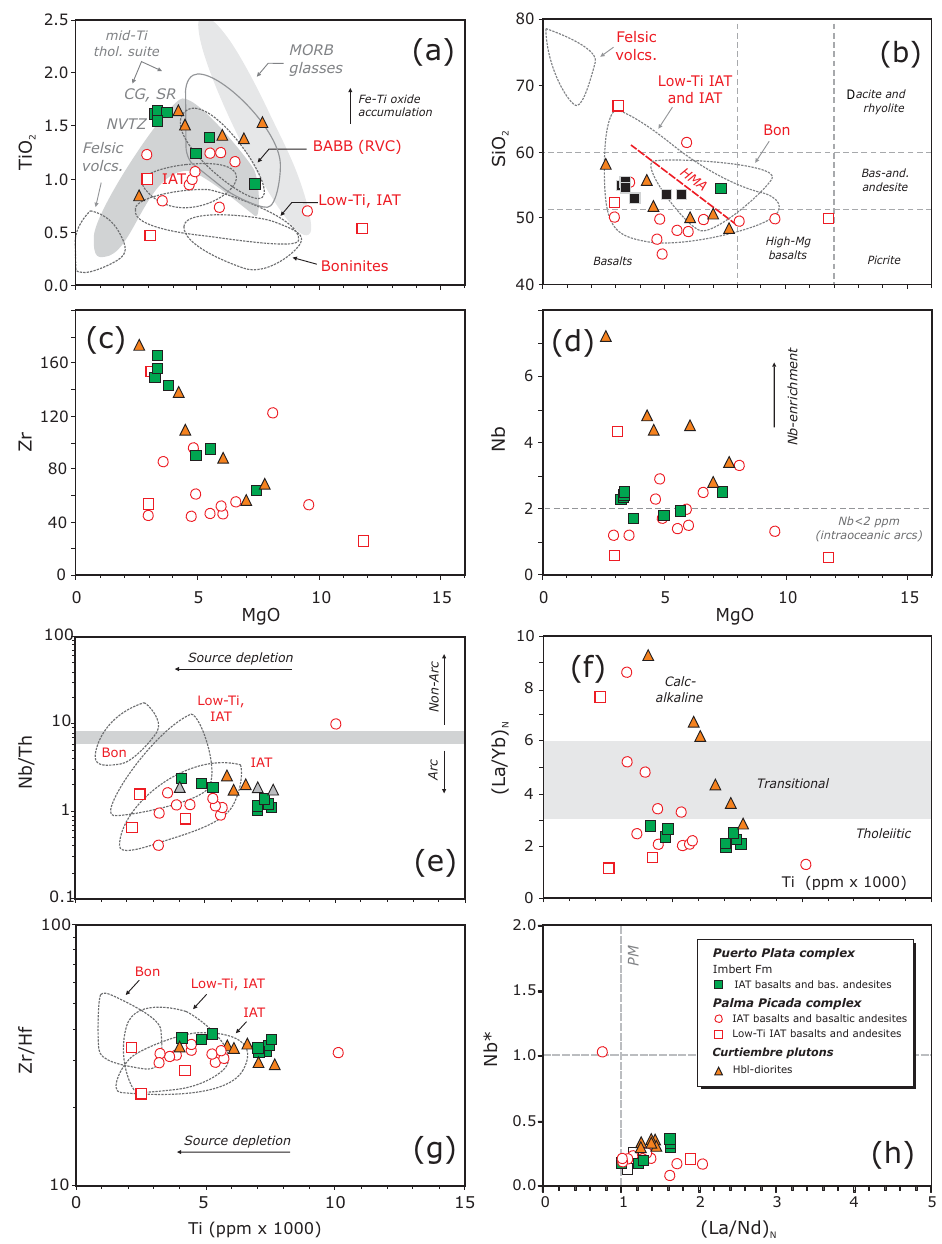
Figure 7. Variation diagrams for rocks from the Imbert Fm, Palma Picada complex and Curtiembre plutons. MgO vs. TiO 2 (a) , SiO 2 (b) , Zr (c) , and Nb (d) . NVTZ, CG, and SR fields are respectively for the northern volcano–tectonic zone, the Central Graben and spreading ridge fields of the Mariana Arc–Trough system, which are shown for comparison. MORB glasses are from a Pacific compilation. The different geochemical groups of Lower Cretaceous igneous rocks in Hispaniola are the following: IAT, normal island-arc tholeiites; low-Ti IAT, low- Ti, and LREE-depleted island-arc tholeiites; Bon, boninites; and felsic volcanic rocks and tonalites. Ti vs. Nb / Th (e) , (La / Yb) N (f) , and Zr, / Hf (g) , and (La / Nd) N vs. Nb ∗ (h) diagrams are for rocks from the same lithological units. See text for